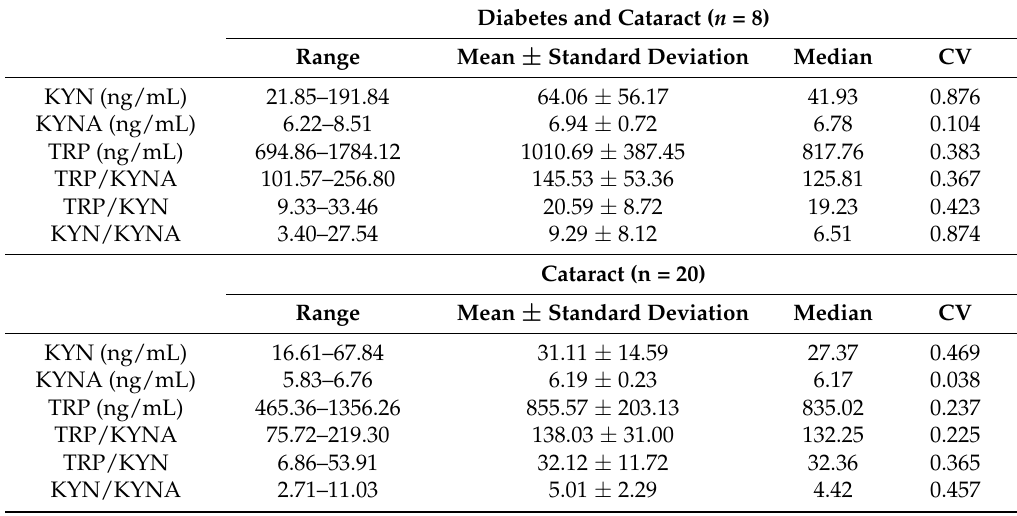
Table 4. The level of TRP, KYNA and KYN [ng/mL] and metabolites ratios determined in eye fluid for the retrospective case series of 28 patients suffered from cataracts including 8 patients with coexisting